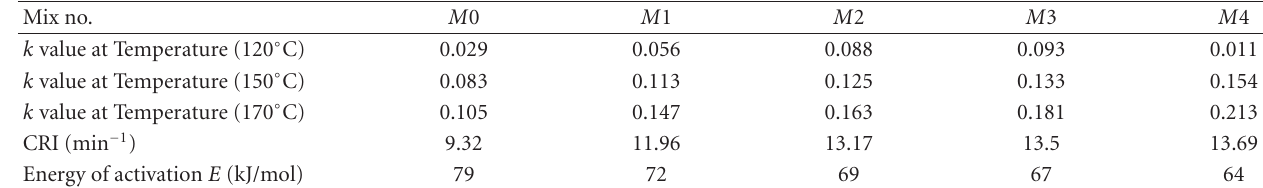
Table 4: Cure kinetics parameters of mixes.